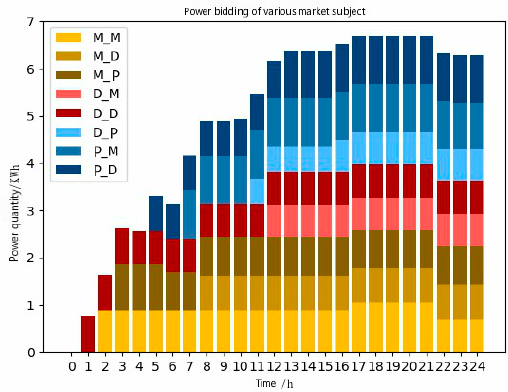
Figure 10. Power bidding of various market subject within 24-hours.